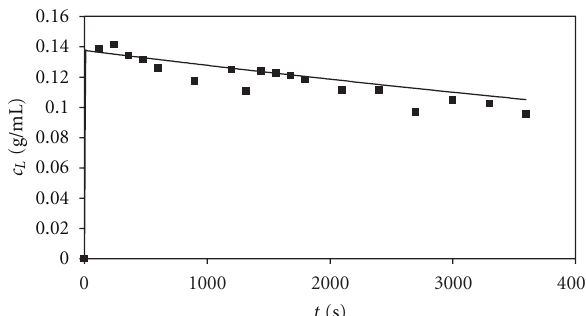
Figure 1: Evolution of oil content at the exit of the extraction column for